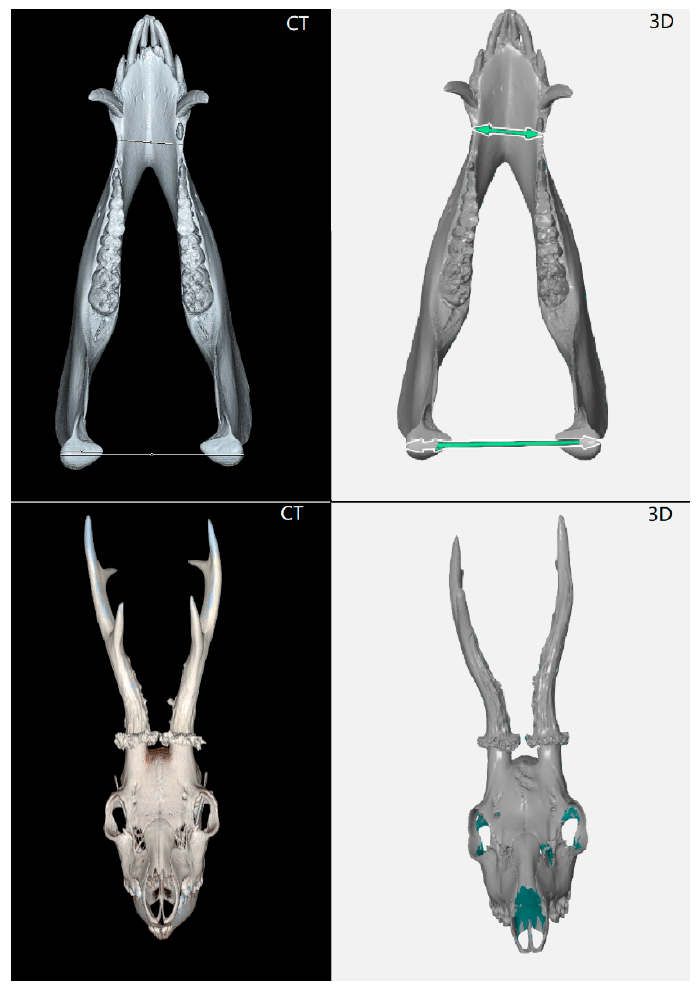
Figure 8. Comparison of imaging capabilities of a CT/3D scanner.